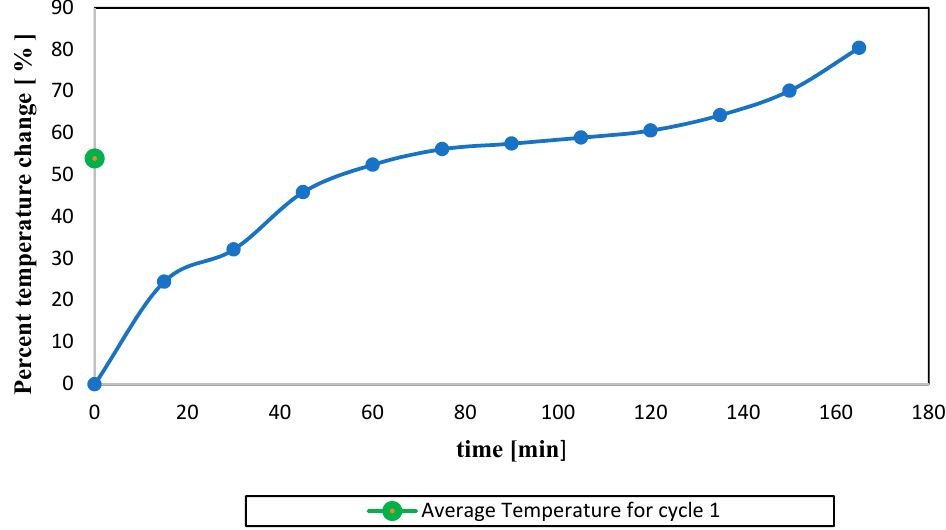
Figure 5. A graph showing temperature out and average temperature lift for cycle 1.